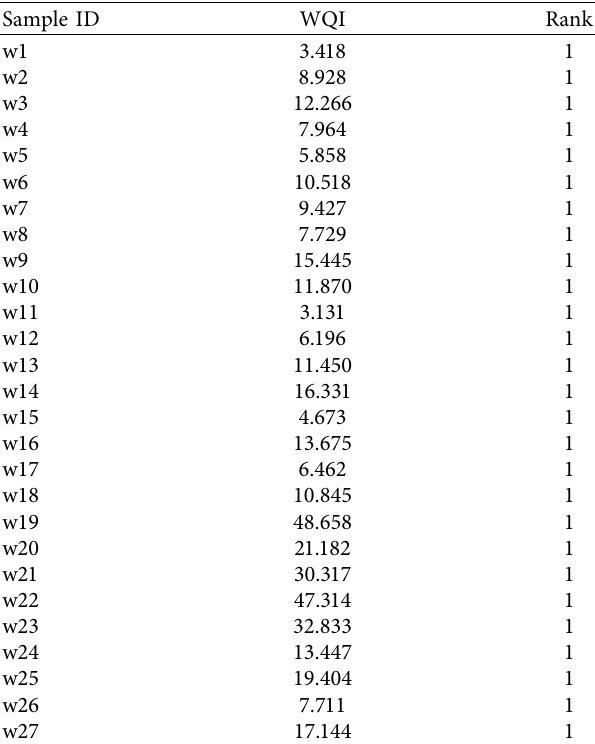
Table 4: Assessment results according to computed